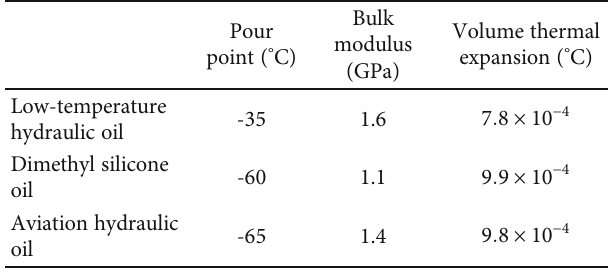
Figure 3: The fabricated water sample: (a) the side lengths of a big square and a small one in the grid is 1cm and 1mm, respectively, and (b) the included angle of the mirrors is 120 ° . Table 1: Physical properties of three commonly used low- temperature hydraulic fl uids, as provided by the